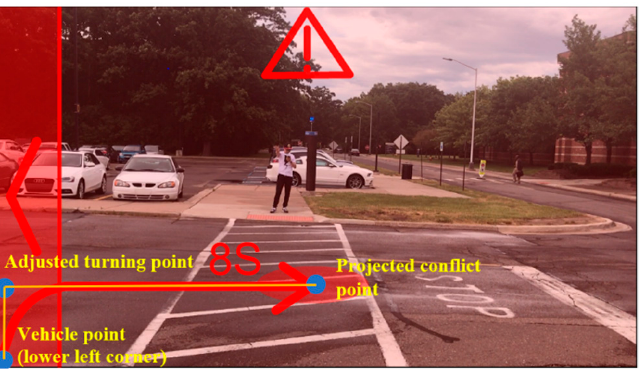
Figure 7. Example of scenario 1: Turning point and vehicle point could not be projected.